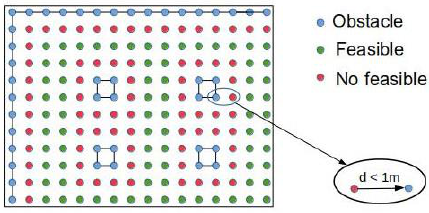
Figure 4. Generation of candidate positions.